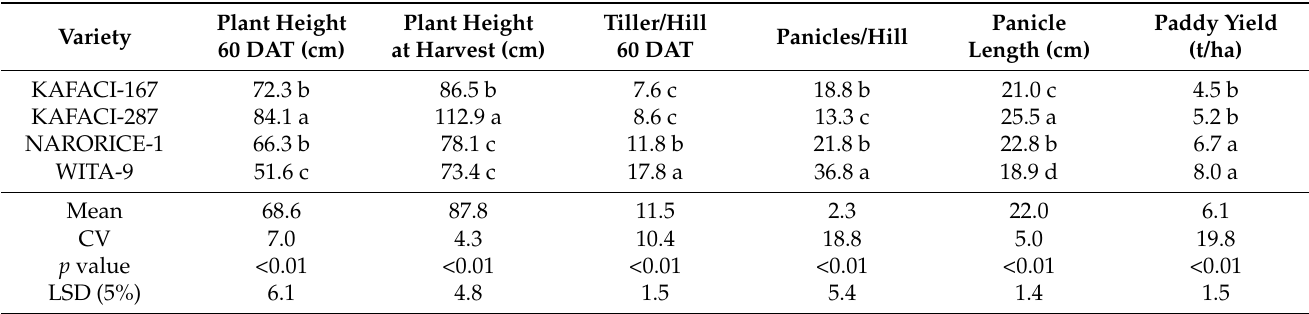
Table 1. Comparison of growth parameters of selected aromatic rice varieties in the Doho rice scheme. Within columns, means values with the same letter are not significantly different.